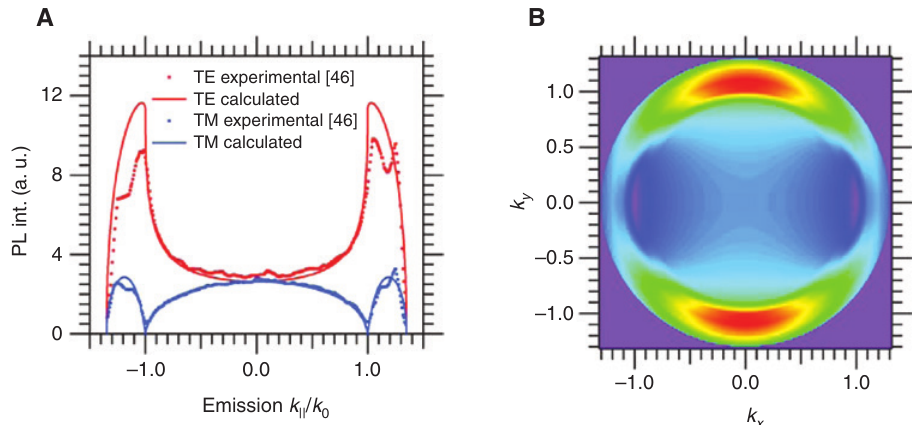
. Experimental data 2